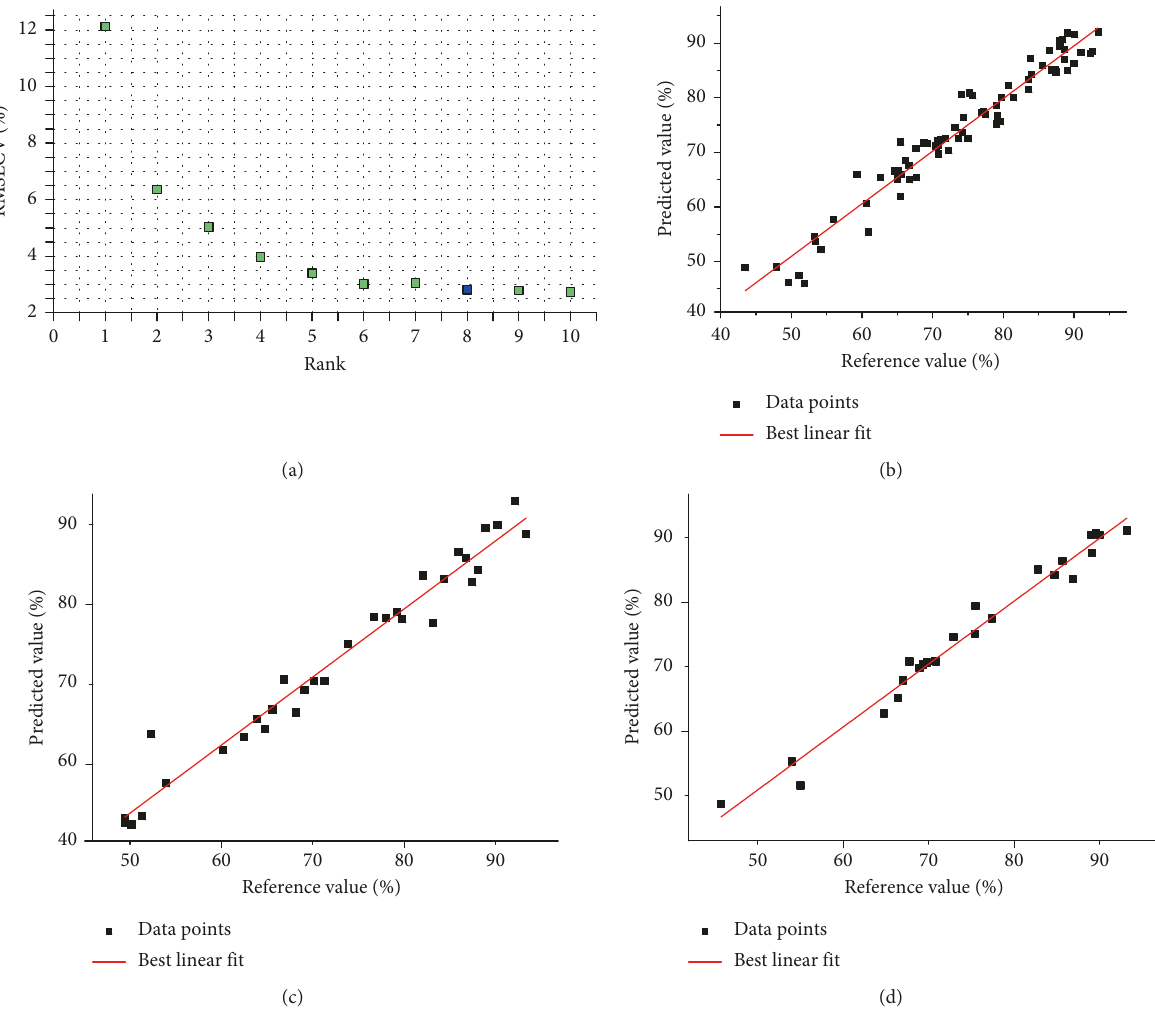
Figure 6: RMSECV-rank correlation diagram (a) and theprediction results of the model for the training set (b), validation set (c), and test set